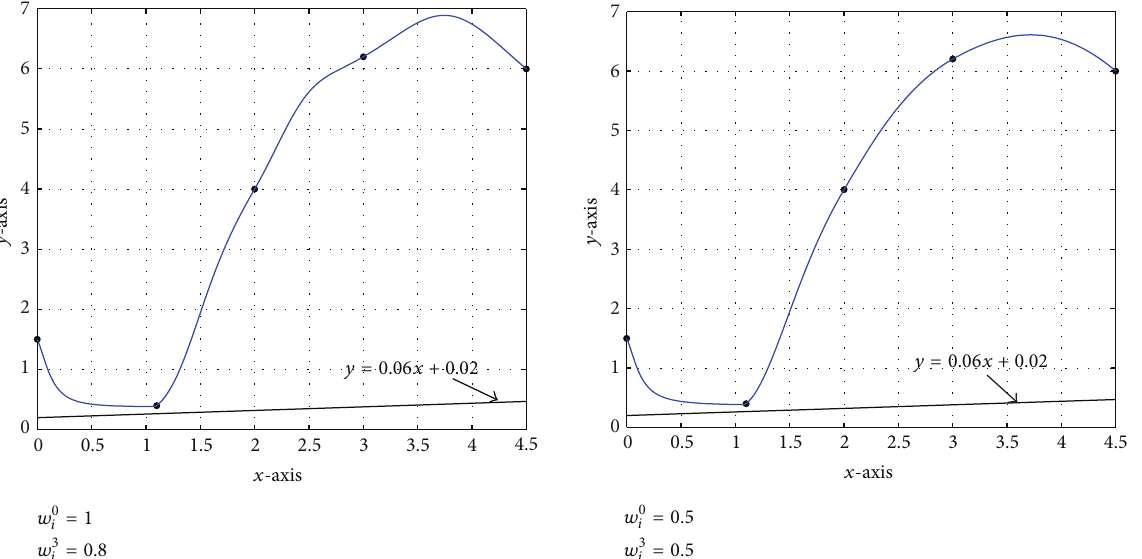
Figure 10: 𝐶 1 rational cubic trigonometric curve lying above the given line with different values of free parameters.